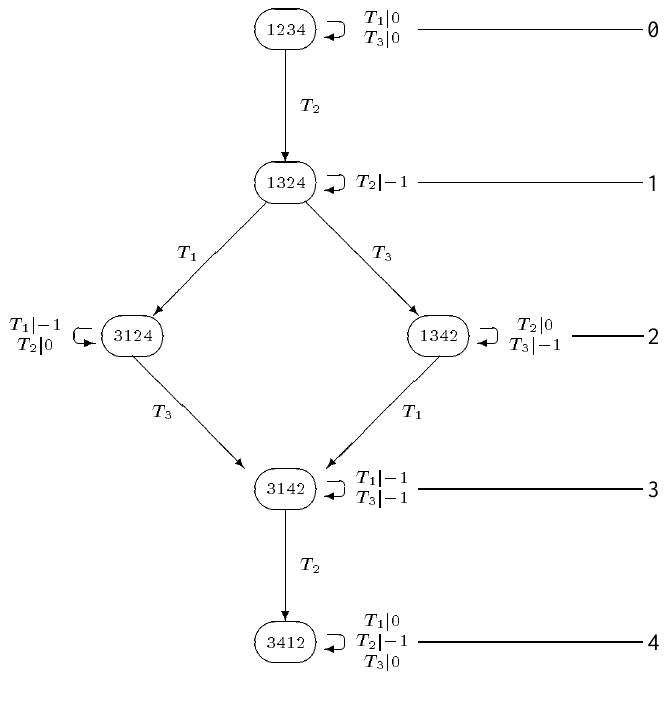
Fig. 2: The image of